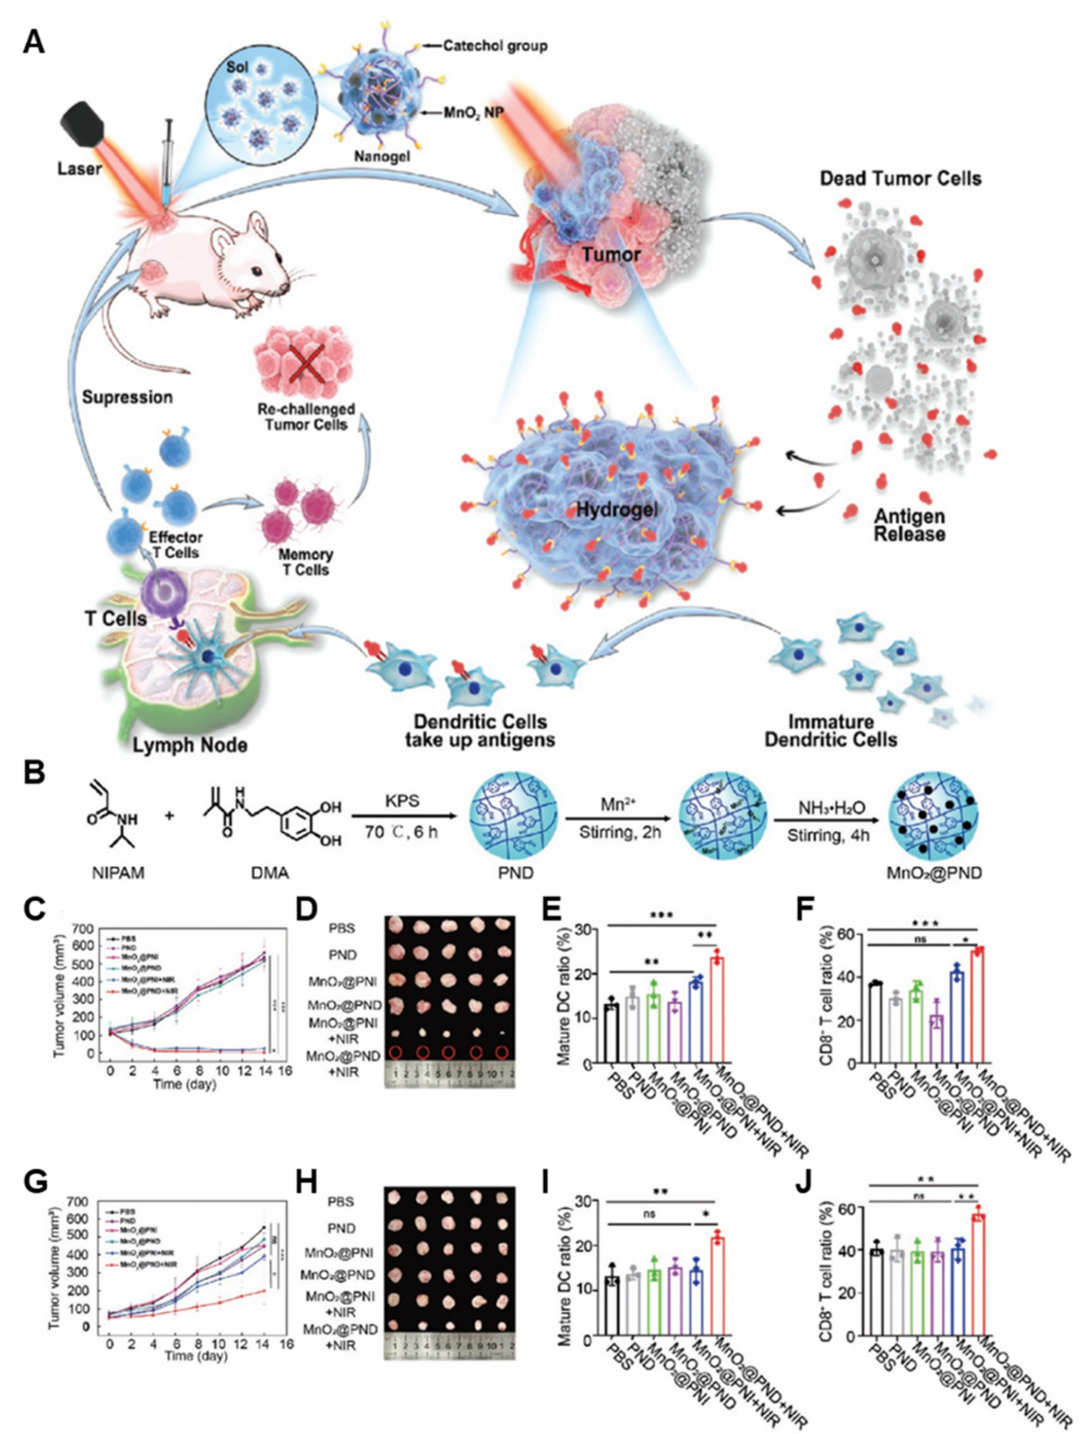
Figure 4. Injectable adhesive hydrogel with MnO 2 NPs for combination photoimmunotherapy. ( A ) Schematic illustration of the mechanism of the antigen-adhered nanogel with MnO 2 NPs, eliciting antitumor immune responses. ( B ) Schematic illustration of MnO 2 NP-loaded hydrogel synthesis. ( C ) Tumor growth curves and ( D ) photographs of primary tumors after treatments. Populations of ( E ) mature DCs in LNs and ( F ) CD8 + T cells in primary tumors were analyzed using flow cytometry. ( G ) Tumor growth curves and ( H ) photographs of secondary tumors after treatments. Populations of ( I ) mature DCs in LNs and ( J ) CD8 + T cells in secondary tumors analyzed using flow